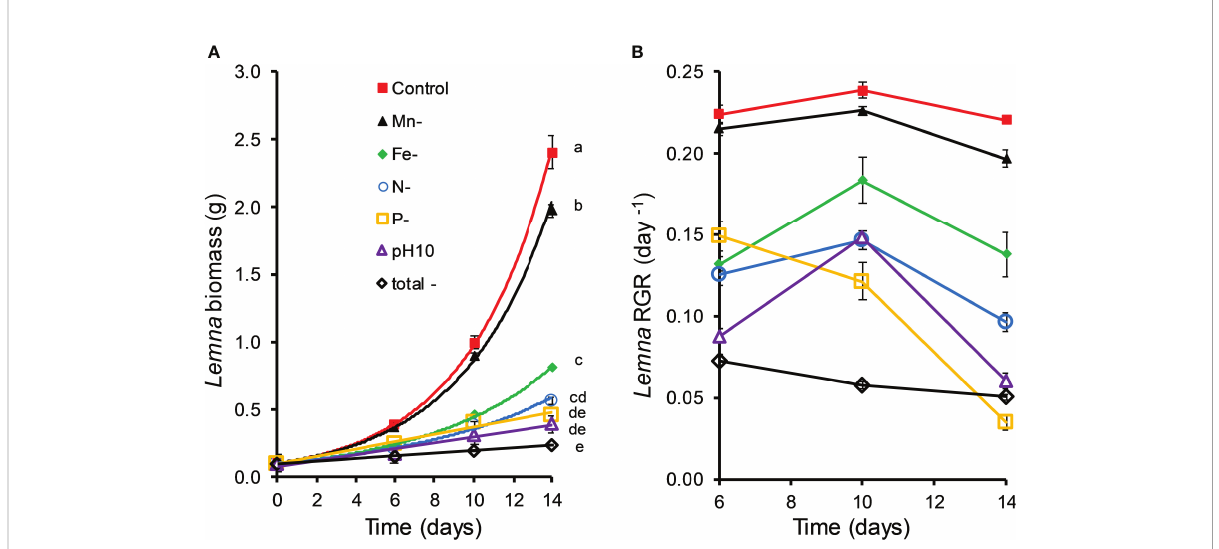
FIGURE 4 Biomass (A) and relative growth rates (RGR) (B) of Lemna gibba grown in nutrient de fi cient (N, P, Fe Mn) and high pH (10.0) media retrieved from co-culture experiments with Ceratophyllum demersum and supplemented with respective nutrients (see Table 2, means ± standard error, n = 4). Signi fi cant differences (oneway ANOVA, Tukey ’ s posthoc test, P < 0.05) among treatments are indicated with different lowercase letters.